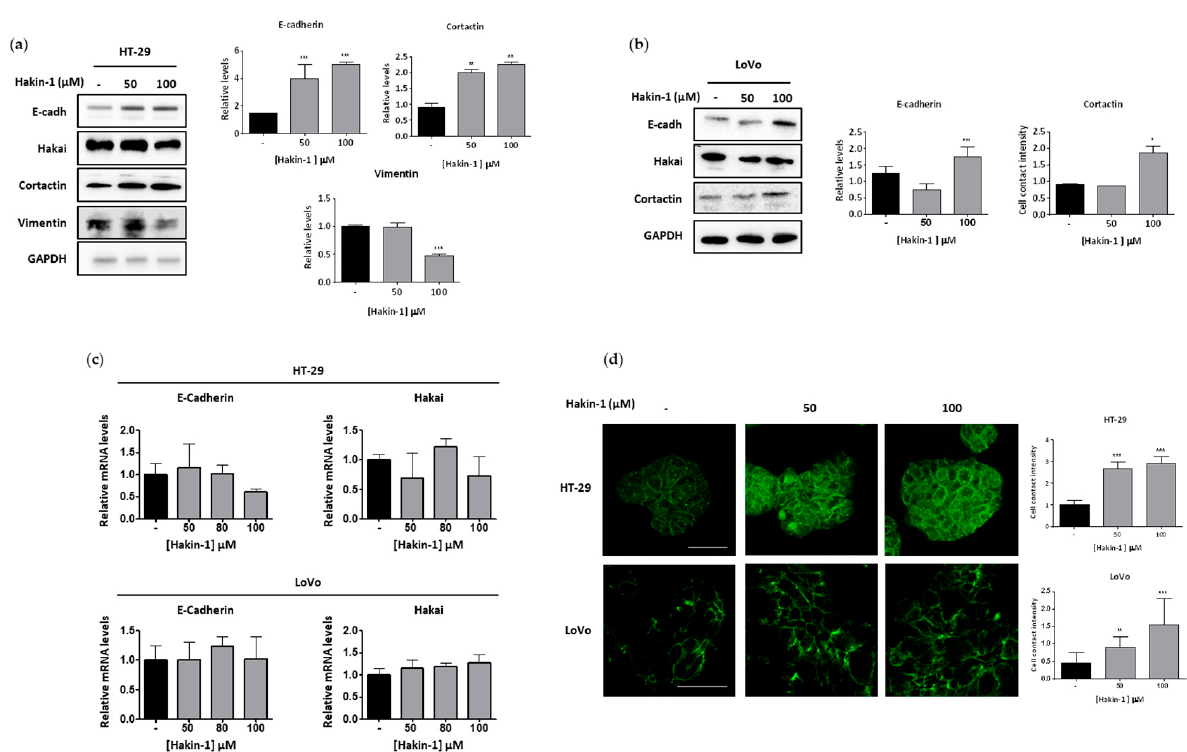
Figure 3. Hakin-1 induces mesenchymal-to-epithelial transition in epithelial tumour cell lines. ( a ) Western blotting analyses of epithelial-to-mesenchymal transition (EMT) markers upon Hakin-1 treatment in HT-29 cell line (left panel), and quantification by densitometry are shown (right panel). ( b ) Western blotting analyses of EMT markers upon Hakin-1 treatment in LoVo cells (left panel), and quantification by densitometry are shown (right panel). GAPDH was used as the loading control. Data show the average of three independent experiments and are represented as mean ± SD (* p < 0.05; ** p < 0.01; *** p < 0.001). ( c ) Hakai and E-cadherin mRNA expression levels normalized to control. RPL13A mRNA were measured in HT-29 and LoVo cells treated with Hakin-1 for 48 h. ( d ) Immunofluorescence of E-cadherin in HT-29 and LoVo cell lines in the presence of DMSO or Hakin-1 treatment after 48 h. Images were obtained with a 20 × objective for HT-29 cells and a 40 × objective for LoVo cells. Quantification was performed with ImageJ programme and results are expressed as mean ± SD of three independent di ff erent experiments (** p < 0.01; *** p < 0.001). Scale bar, 50 µ m for HT-29 cells and 175 µ m for LoVo cells. Moreover, Hakin-1 did not modulate the mRNA levels of E-cadherin or Hakai confirming that its activity is mostly to control target protein degradation (Figure 3c). Hakin-1 increased the amount of E-cadherin levels at cell–cell contacts in HT-29 and LoVo cells, as detected by immunofluorescence (Figure 3d). However, no effect was detected on protein levels or localization of E-cadherin upon Hakin-5 treatment in HT-29 cells (Figure S6). Finally, we observed that Hakin-1 did not increase E- cadherin expression in Hakai-MDCK cells which, as previously reported, had a complete lack of E- cadherin basal levels [38,41]. Taken together, these results demonstrate that Hakin-1 induces epithelial differentiation in different tumour cells that is accompanied by a reduction of mesenchymal markers. 2.4. Hakin-1 Inhibits Proliferation, Oncogenic Potential and Invasiveness of Epithelial Tumour Cells Given that Hakai affects not only cell–cell contacts but also proliferation in fibroblast and epithelial cells [38], we decided to determine the possible effect of Hakin-1 on proliferation. Indeed, Hakin-1 (Figure 4a) but not Hakin-5 (Figure 4b) reduced cell proliferation in HT-29 and LoVo cells. Moreover, we confirmed that MDCK cells strongly proliferated when Hakai was overexpressed (Figure 4c). Interestingly, Hakin-1 was able to suppress proliferation of Hakai-MDCK cells whereas MDCK control cells were unaffected (Figure 4c). These results suggest that Hakin-1 may function as